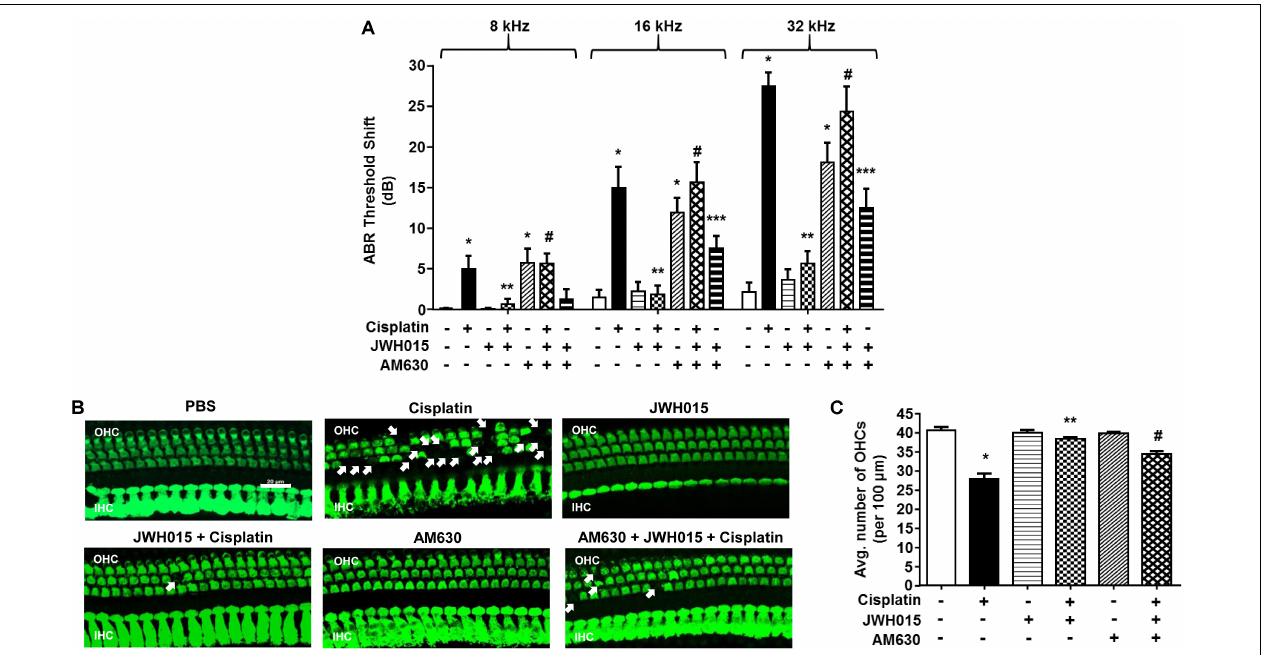
FIGURE 3 | Trans -tympanic administration of JWH015 prevents cisplatin-induced hearing loss. (A) Baseline ABR thresholds were recorded in Wistar rats, which were then pre-treated with either trans -tympanic AM630 (2.5 nmoles) for 30 min followed by trans -tympanic JWH015 (2.5 nmoles) or individually with trans -tympanic AM630 or JWH015 for 24 h. Cisplatin (11 mg/kg) was then administered (i.p.) after day 1 and post-ABR was performed after 72 h. Pre-treatment with JWH015 diminished cisplatin-induce ABR threshold shift in all the three frequency regions. The protective action of JWH015 was completely blocked by AM630. Trans -tympanic administration of AM630 alone significantly elevated by ABR thresholds. Data (threshold shift) is plotted as mean ± SEM ( n = 12). (B) The animals were sacrificed at the end point and cochleae were collected, fixed by 4% PFA in PBS followed by decalcification for 3 weeks in 100 mM EDTA. The base of the cochlea were dissected out and stained with hair cell marker, myosin VIIa, to determine the hair cell loss. Representative images are shown. Scale bar is 20 µ m. (C) The bar graph represents the average number of hair cells per 100 µ m area shown in (B) ( n ≥ 3). Pre-treatment with JWH015 reduced cisplatin-induced outer hair cell loss. Administration of AM630 produced no hair cell loss. ∗ p < 0.05 vs. vehicle; ∗∗ p < 0.05 vs. cisplatin; # p < 0.05 vs. JWH015 + cisplatin; and ∗∗∗ p < 0.05 vs. JWH015 (one-way